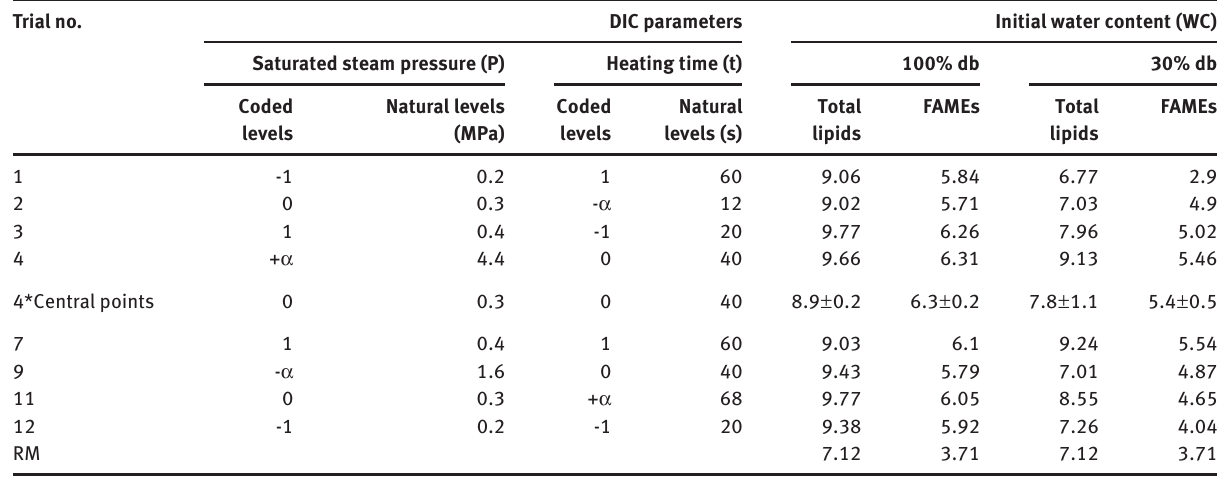
Table 1 Independent variables and their coded and natural levels employed in central composite design to optimize the effect of instant controlled pressure drop (DIC) on total lipids and fatty acid methyl esters (FAMEs) yield from DIC-treated microalgae; response values are also included.